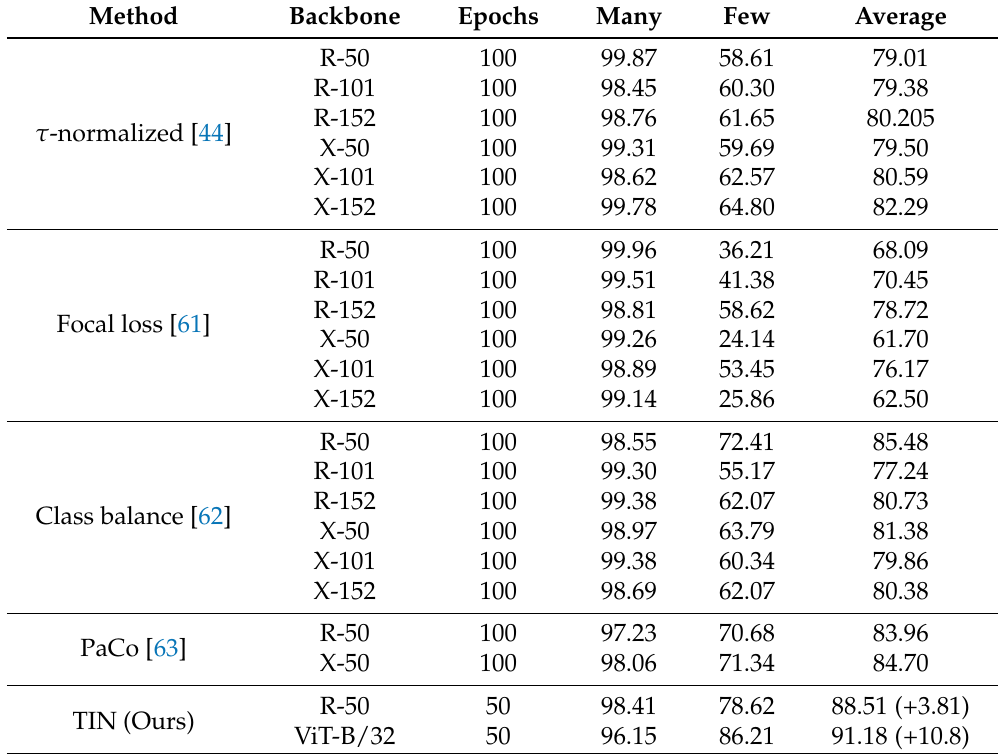
Table 3. Results obtained using the clamp dataset.